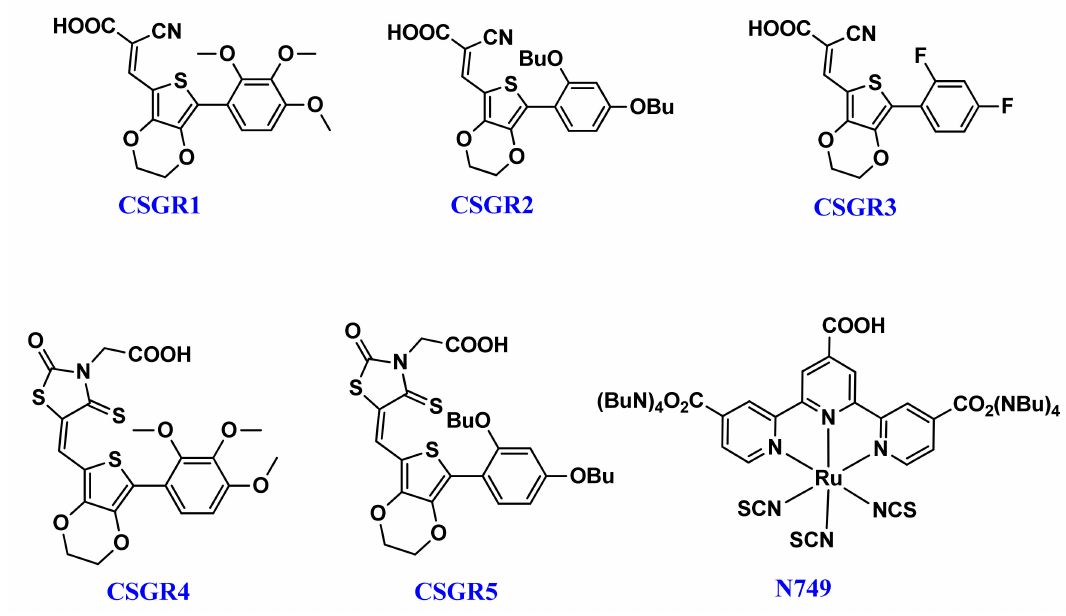
Figure 1. Chemical Structures of CSGR1-5